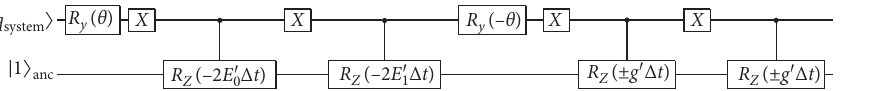
〉 represents the system’s qubit state system